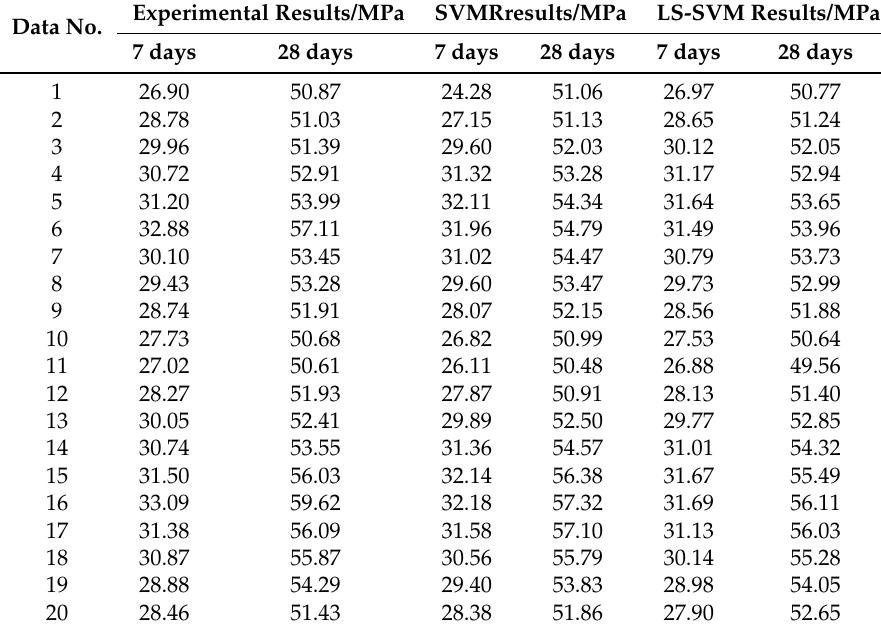
Table 6. Comparison of compressive strength measured and predicted results. Data